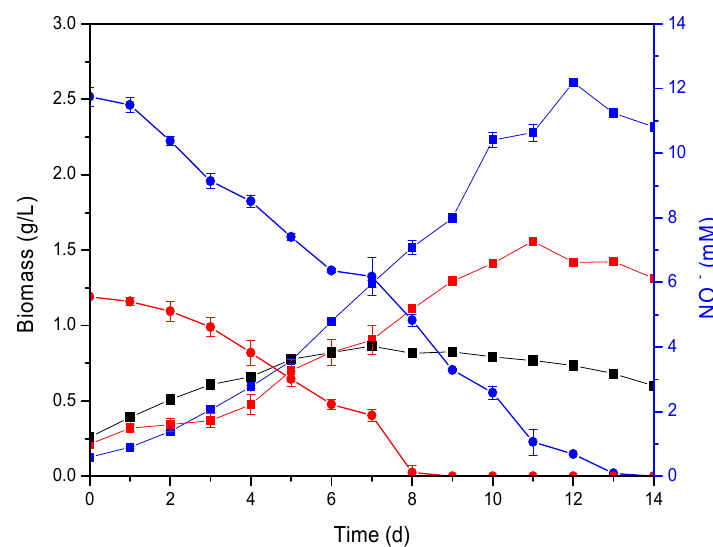
Figure 3. Growth curve (squares) and nitrate uptake (circles) for cultures of P. tricornutum under a 18:6-h photoperiod with continuous CO 2 injection starting with different initial nitrate concentrations: 11.8 mM (blue symbols), 5.9 mM (red symbols) and 0 mM (black symbols).